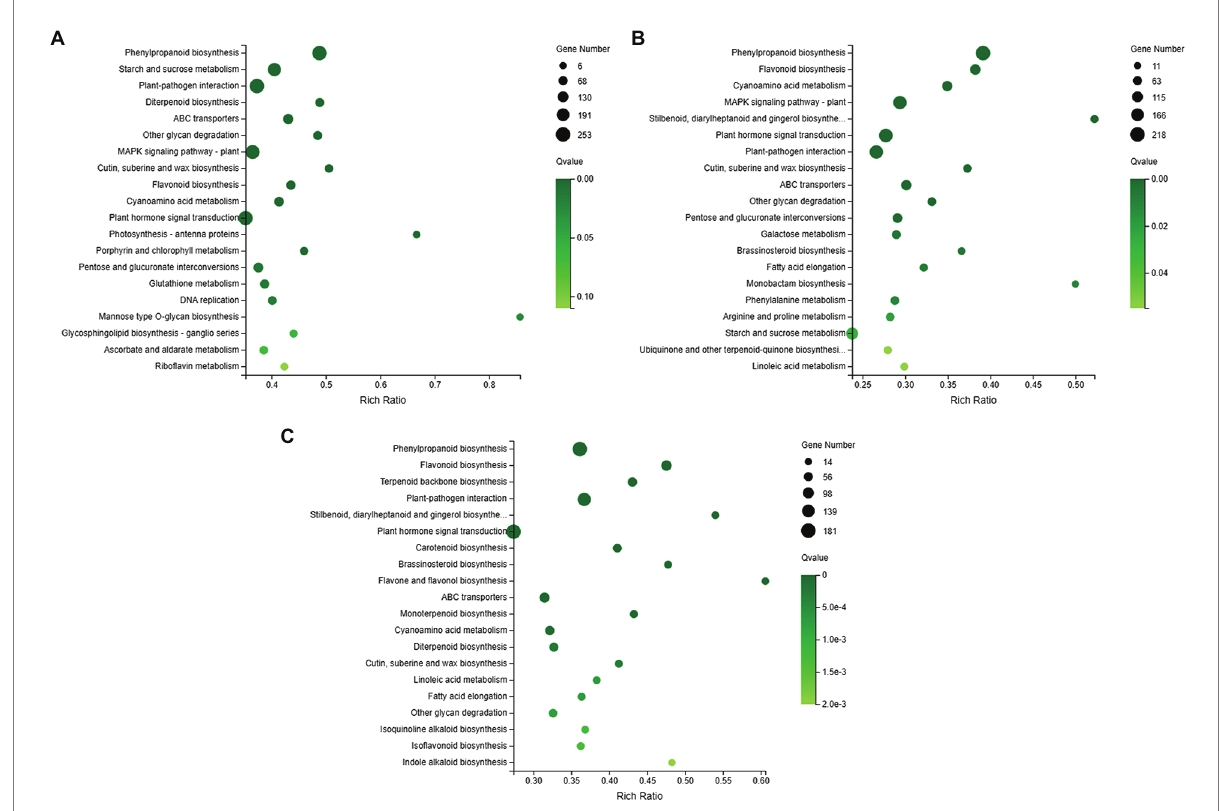
FIGURE 4 Overview of KEGG enrichments for C. ensifolium (A) , C. goeringii (B) , and C. sinense (C) . The y-axis shows the KEGG pathway names and the x-axis shows the pathway-richness ratio. The size of the black circles shows the number of genes enriched to each pathway; bigger the circle size more is the number of